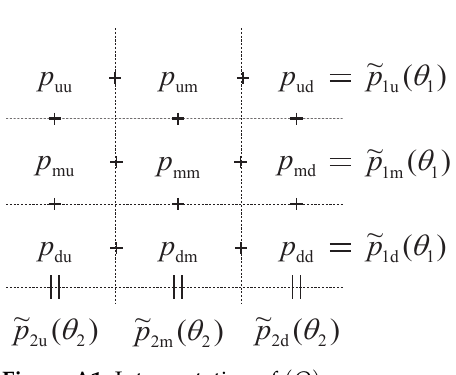
Figure A1. Interpretation of ( Q )